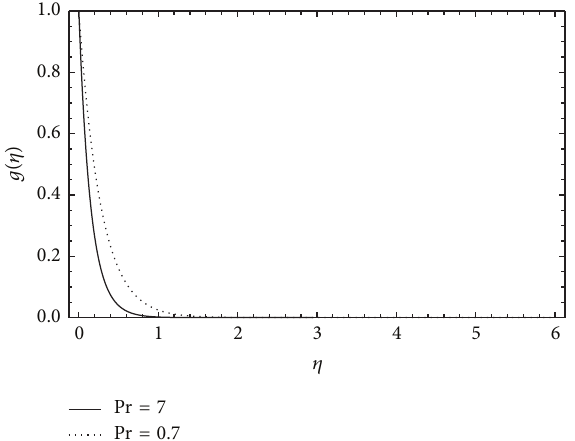
Figure 11: Variation of temperature profiles with Pr for 𝑀 = 𝑁 = 1 and 𝐾 𝑤 = −2 .